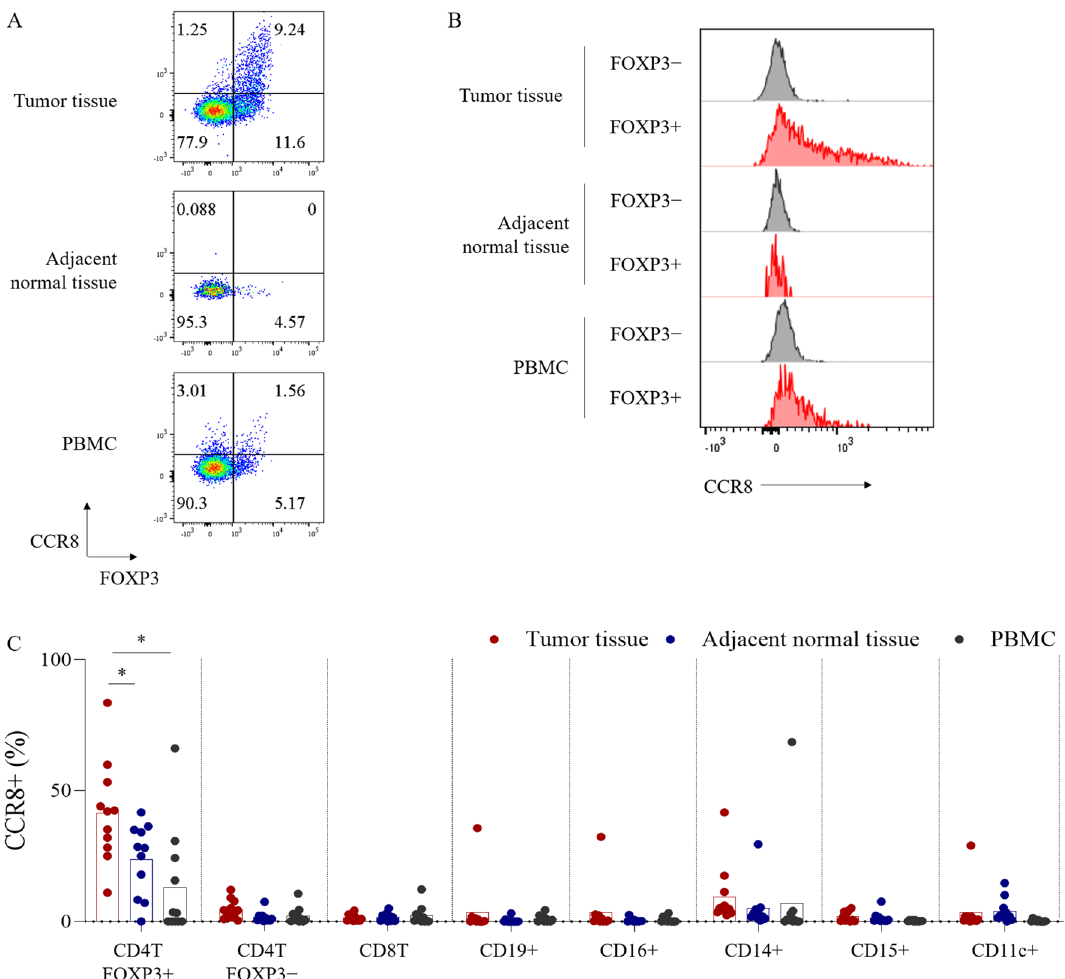
Figure 1. CCR8 expression on immune cells of lung cancer patients. Single cell suspensions isolated from lung tumor tissues, tumor-adjacent normal tissues and PBMCs were analyzed by flow cytometry. ( A ) FOXP3 and CCR8 expressions on CD4 T cells (gated on live CD45+ CD3+ CD4+ cells). ( B ) CCR8 expression on FOXP3+ or FOXP3− CD4 T cells. Representative flow cytometric data are shown. ( C ) Percentages of CCR8+ cells in FOXP3+ CD4 T, FOXP3− CD4 T, CD8 T, CD19+, CD16+, CD14+, CD15+, and CD11c+ cell subsets in lung tumors, tumor-adjacent normal tissues and PBMCs (n = 11). Data are shown as mean values ± SD. Statistical significance was determined by paired t-test (* p ≤ 0.05; ** p < 0.01) compared with tumor infiltrating FOXP3+ CD4 T cell